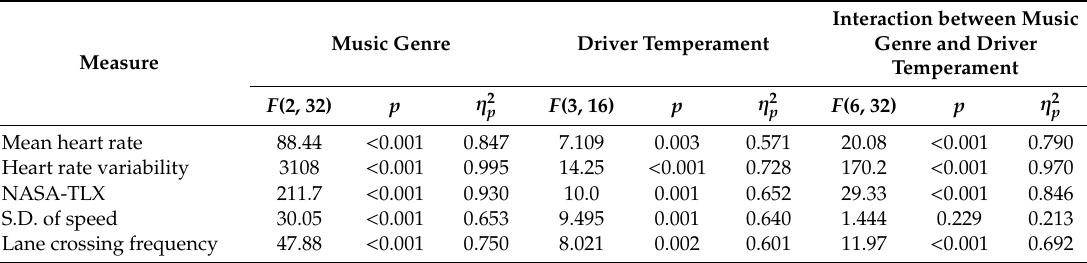
Table 1. The results of M-ANOVA.